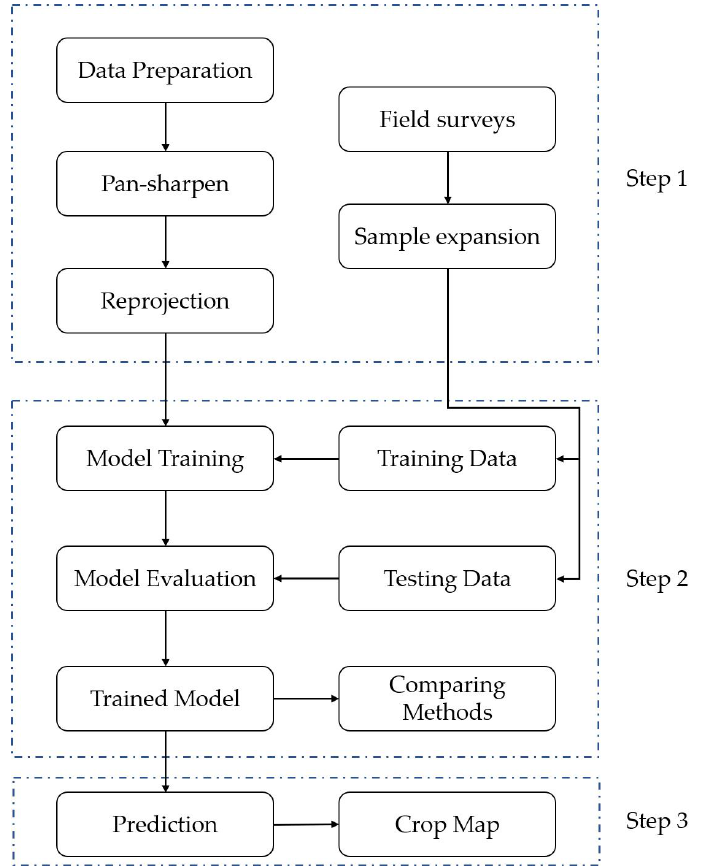
Figure 6. Overview of the proposed framework for crop